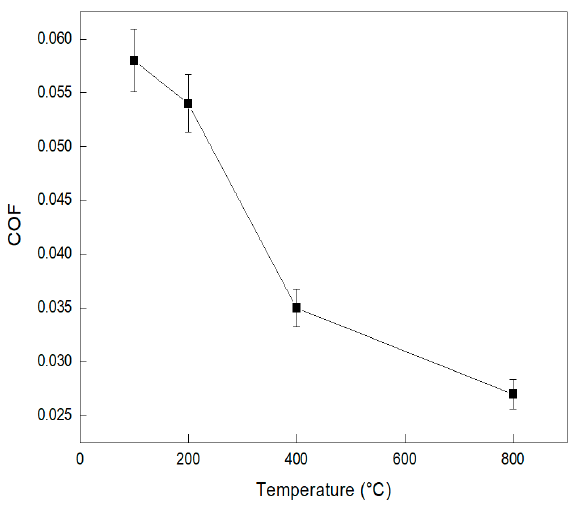
Figure 11. COF values for HfCN coatings during the 500 m as a function of temperature.